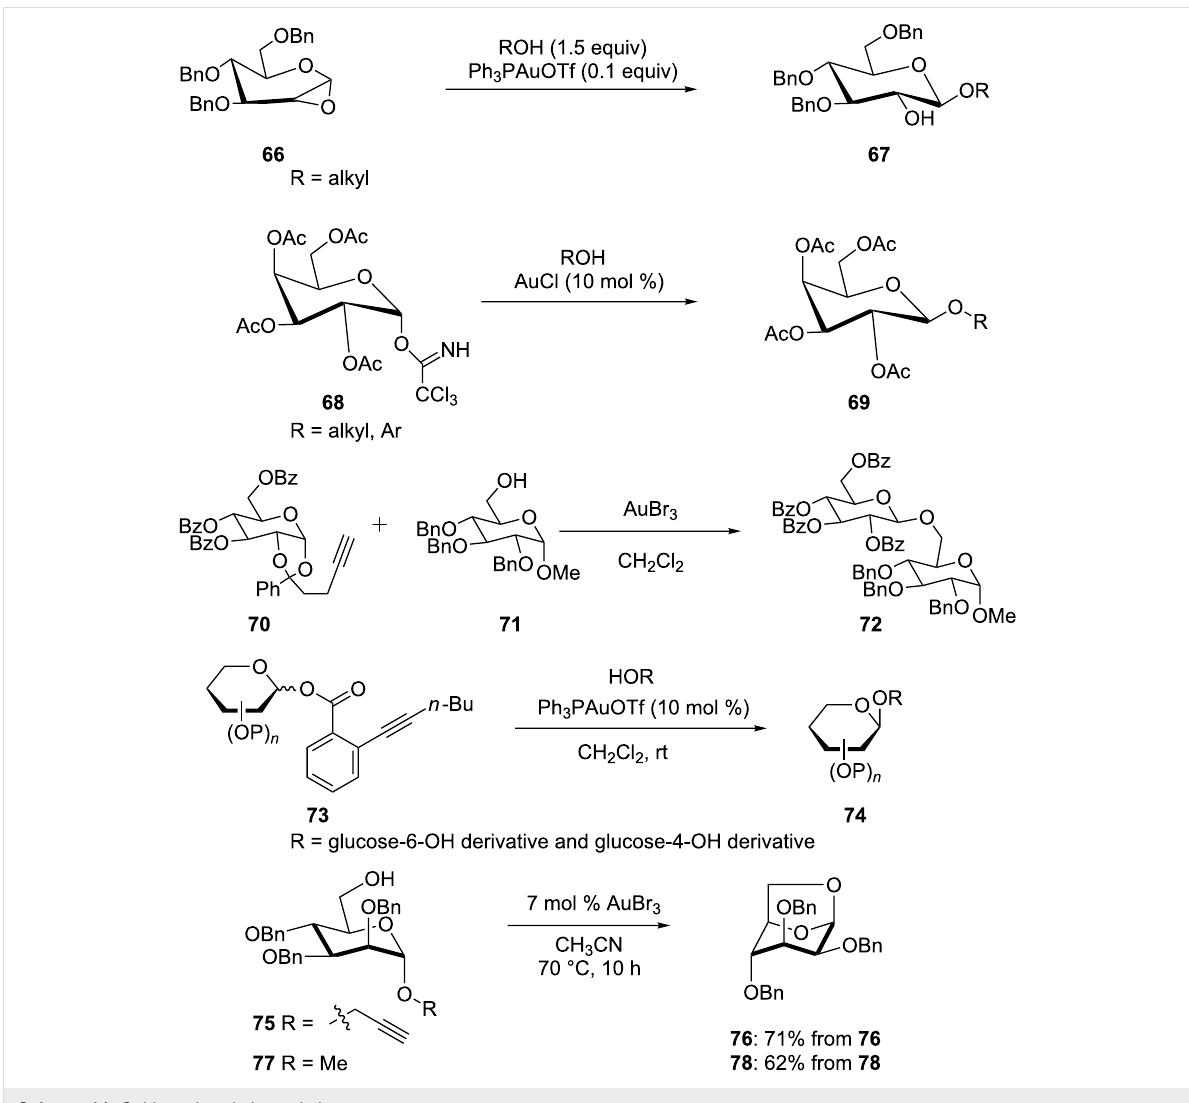
Scheme 14: Gold-catalyzed